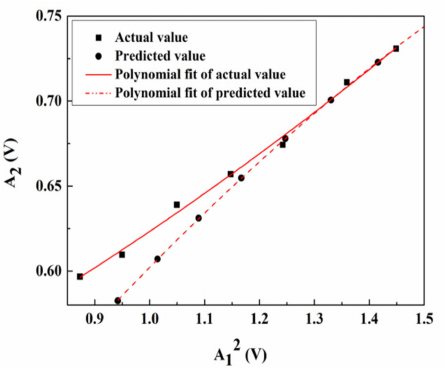
Figure 12. Ratio of A 2 to A 1 2 with increasing excitation